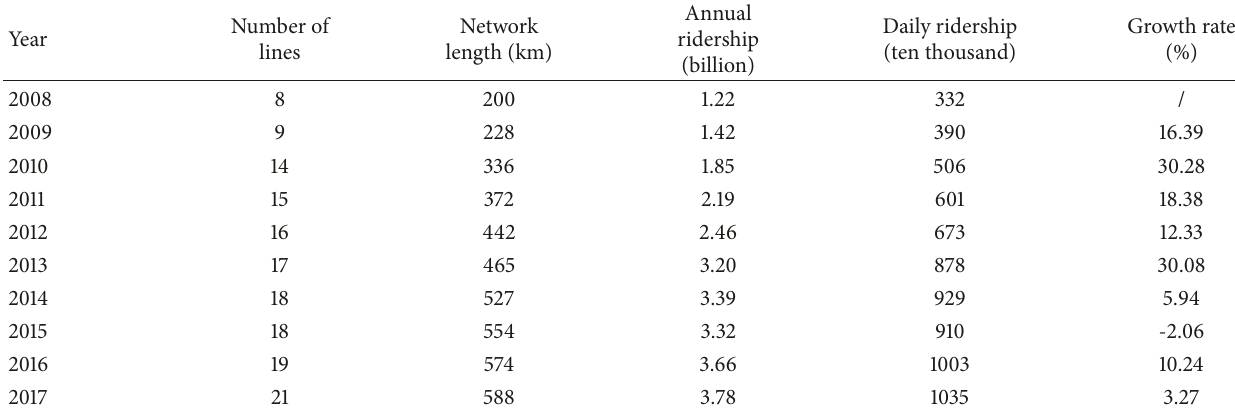
Table 1: Development of the Beijing subway in the last decade.